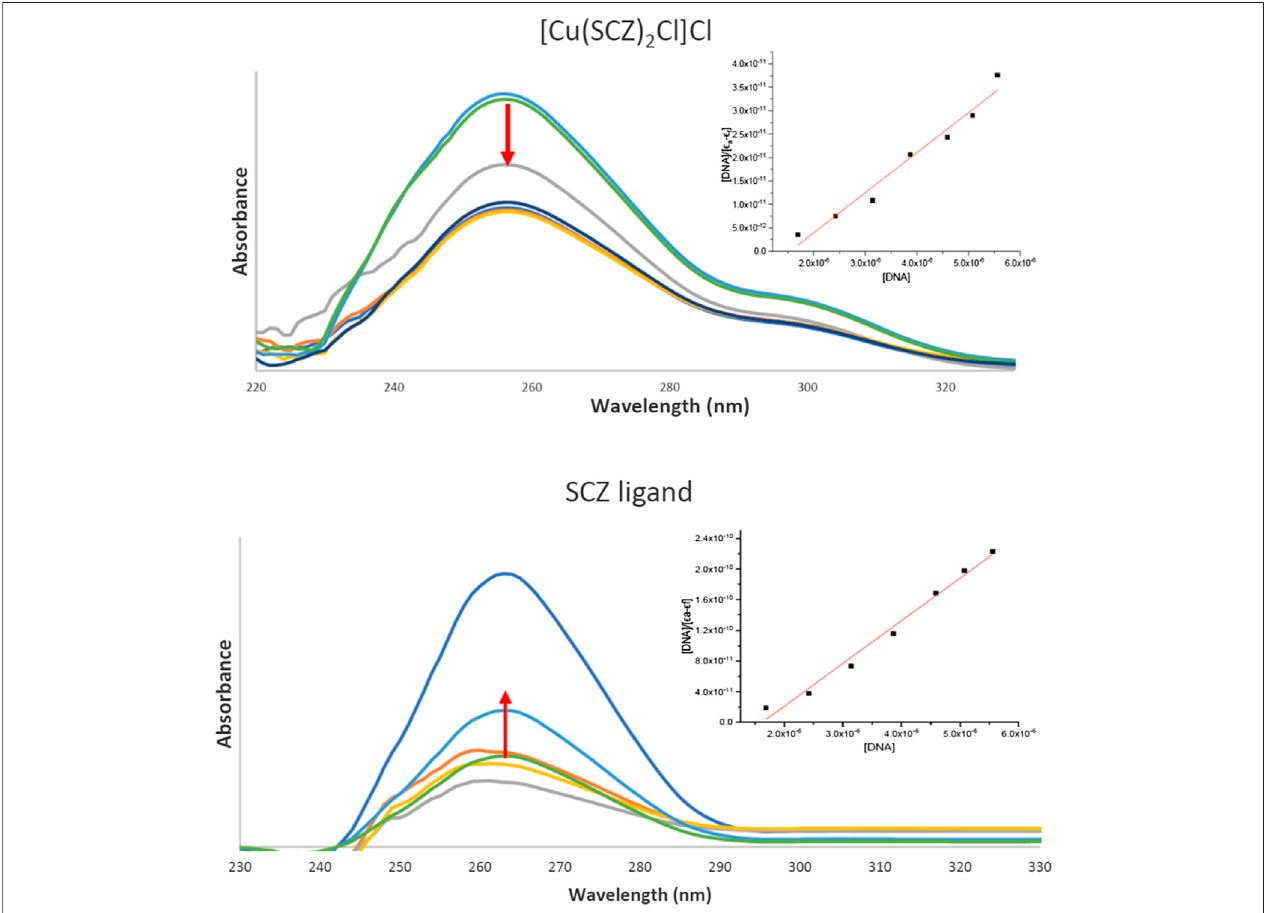
FIGURE7| UV absorption spectra ofthe[Cu(SCZ) 2 Cl 2 ] complex (A) and theligand SCZ (B) inabuffer upon the addition ofCT-DNA. Plots of[DNA]vs. [DNA]/ ϵ a - ϵ f for the titration of CT-DNA.